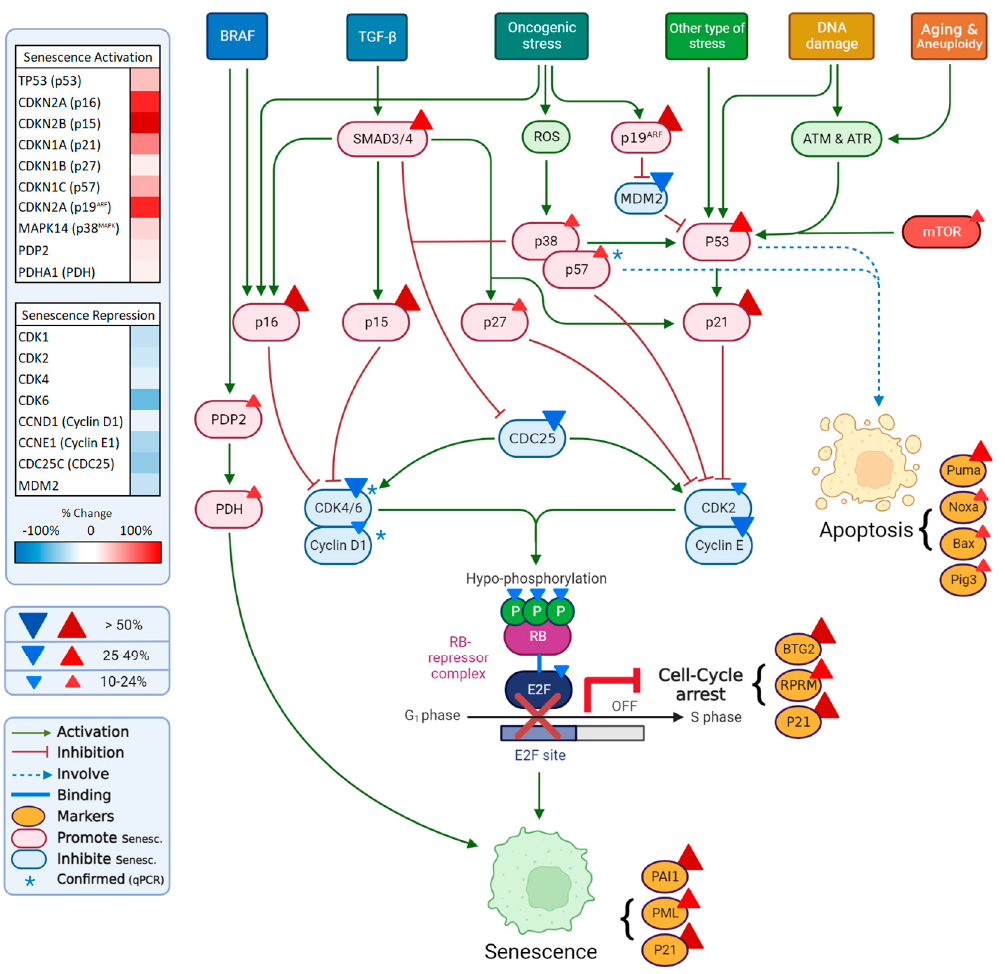
Figure 8. Gene expression changes related to cellular senescence and apoptosis. Expression changes in related genes based on the NGS data are shown on the left upper panel. Changes that were con ‐ firmed by RT ‐ qPCR are marked with blue asterisks.